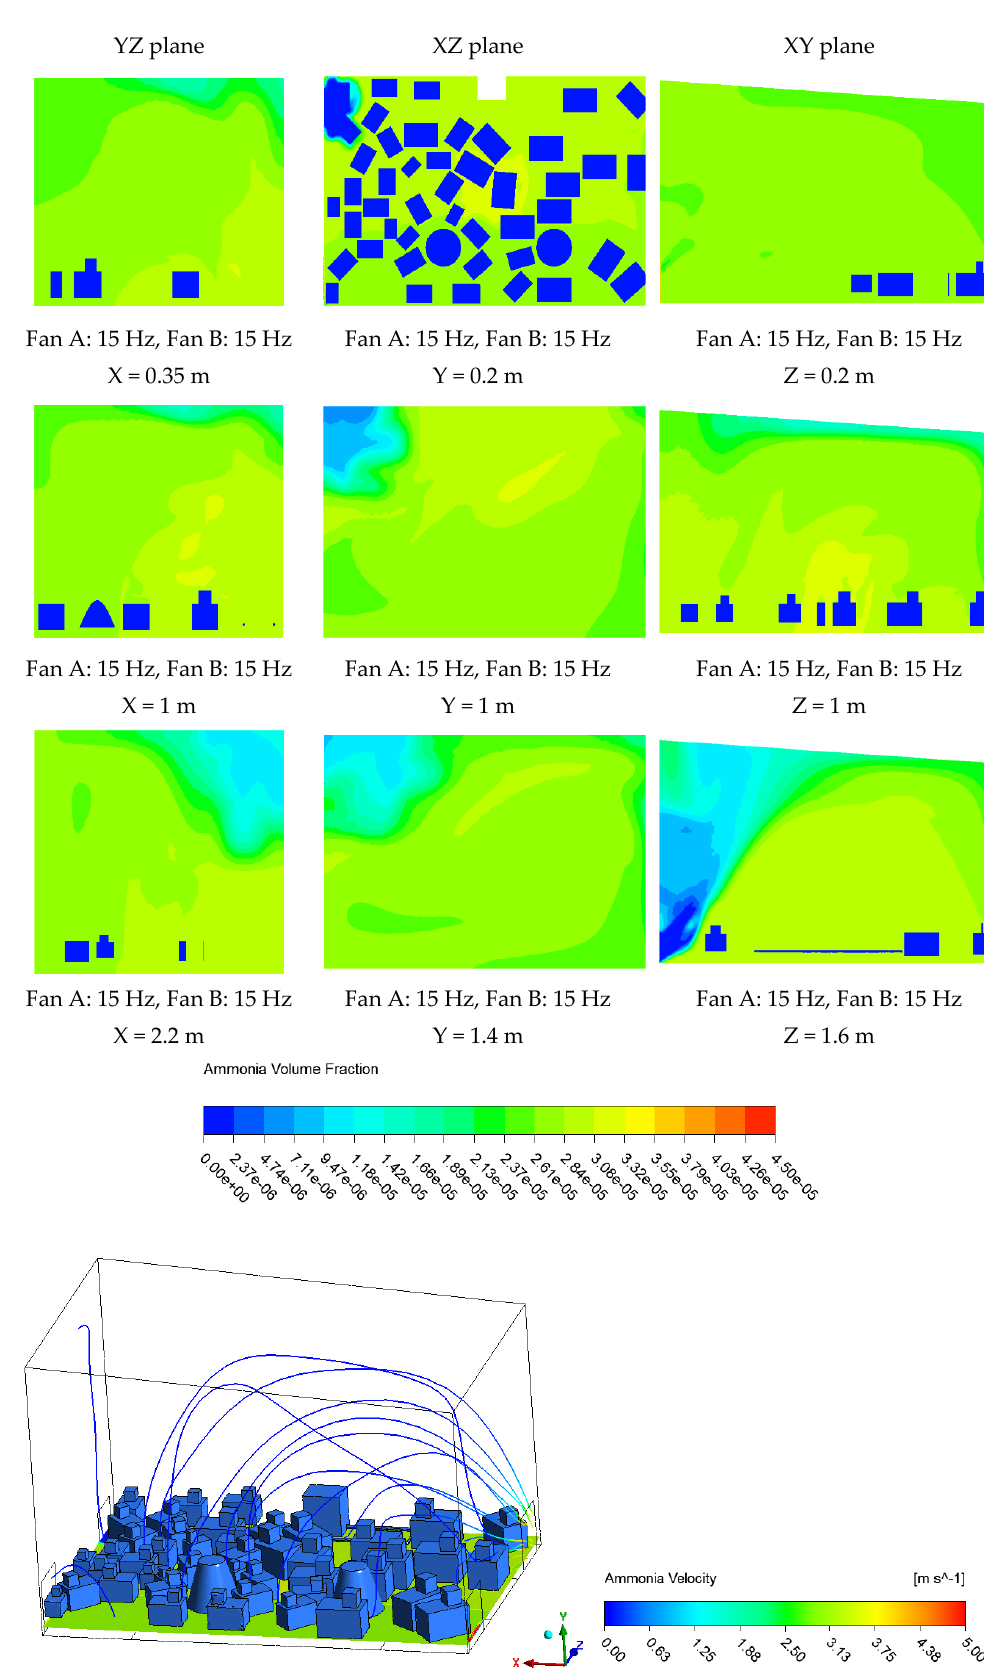
Figure 9. Simulation results of ammonia concentration distribution under working condition 1.